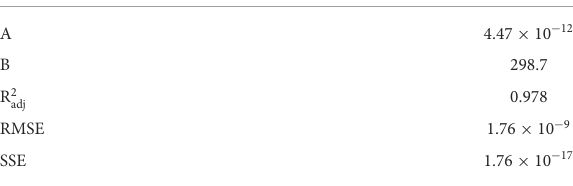
TABLE 1 Estimated parameter and statistical results for skin permeability of onion bulbs. Parameters and statistical